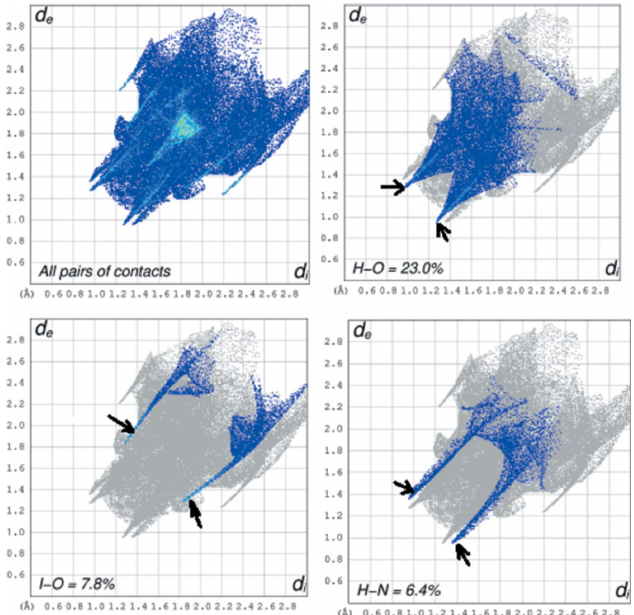
Figure 5 Selected two-dimensional fingerprint plots of structure (I); d i and d e are the distances from the Hirshfeld surface to the nearest internal and external atoms. Arrows indicate the ‘spikes’ characteristic of hydrogen and halogen bonds